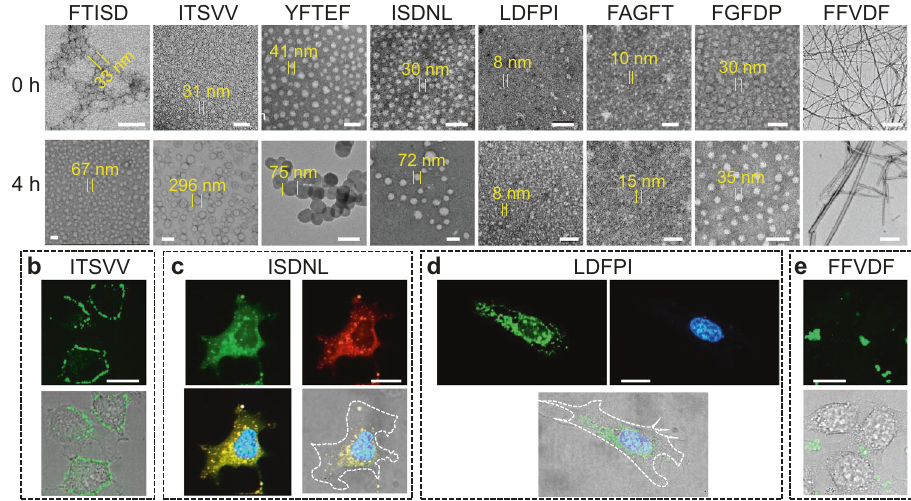
Fig. 4 Structure transformation and cellular distribution of pentapeptide-based nanomaterials. a TEM images of 40 μ M chemically synthesized FTISD, ITSVV, YFTEF, ISDNL, LDFPI, FAGFT, FGFDP, and FFVDF “ solubilized ” in H 2 O with 1% DMSO for 0 and 4 h. The scale bar is 100 nm for FTISD, YFTEF, ISDNL, LDFPI, FAGFT, and FGFDP at both 0 h and 4 h, and ITSVV at 0 h. The scale bar is 500 nm for FFVDF at both 0 and 4 h and ITSVV at 4 h. b − e Pentapeptide assemblies (40 μ M) interaction with live HeLa cells. ITSVV ( b ) localized on the cell membrane, ISDNL ( c ) distributed inside the lysosomes throughout the cytoplasm, LDFPI ( d ) localized to the nucleus and perinuclear areas, and FFVDF ( e ) formed aggregates outside the cell. Green denotes fl uorescein isothiocyanate (FITC)-labeled pentapeptides. Red (Lyso-Tracker Red) denotes lysosomes, blue (Hoechst 33324) is nucleus. The scale bar is 20 μ m. The white dash line outlines the cell